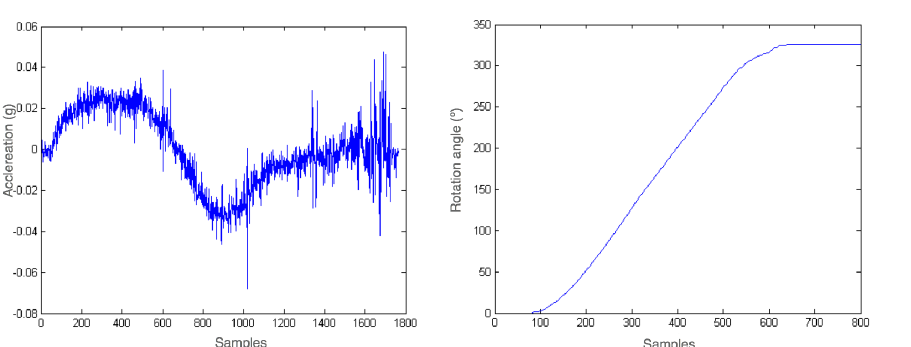
Figure 6. Extraction of the rotation of a rotated